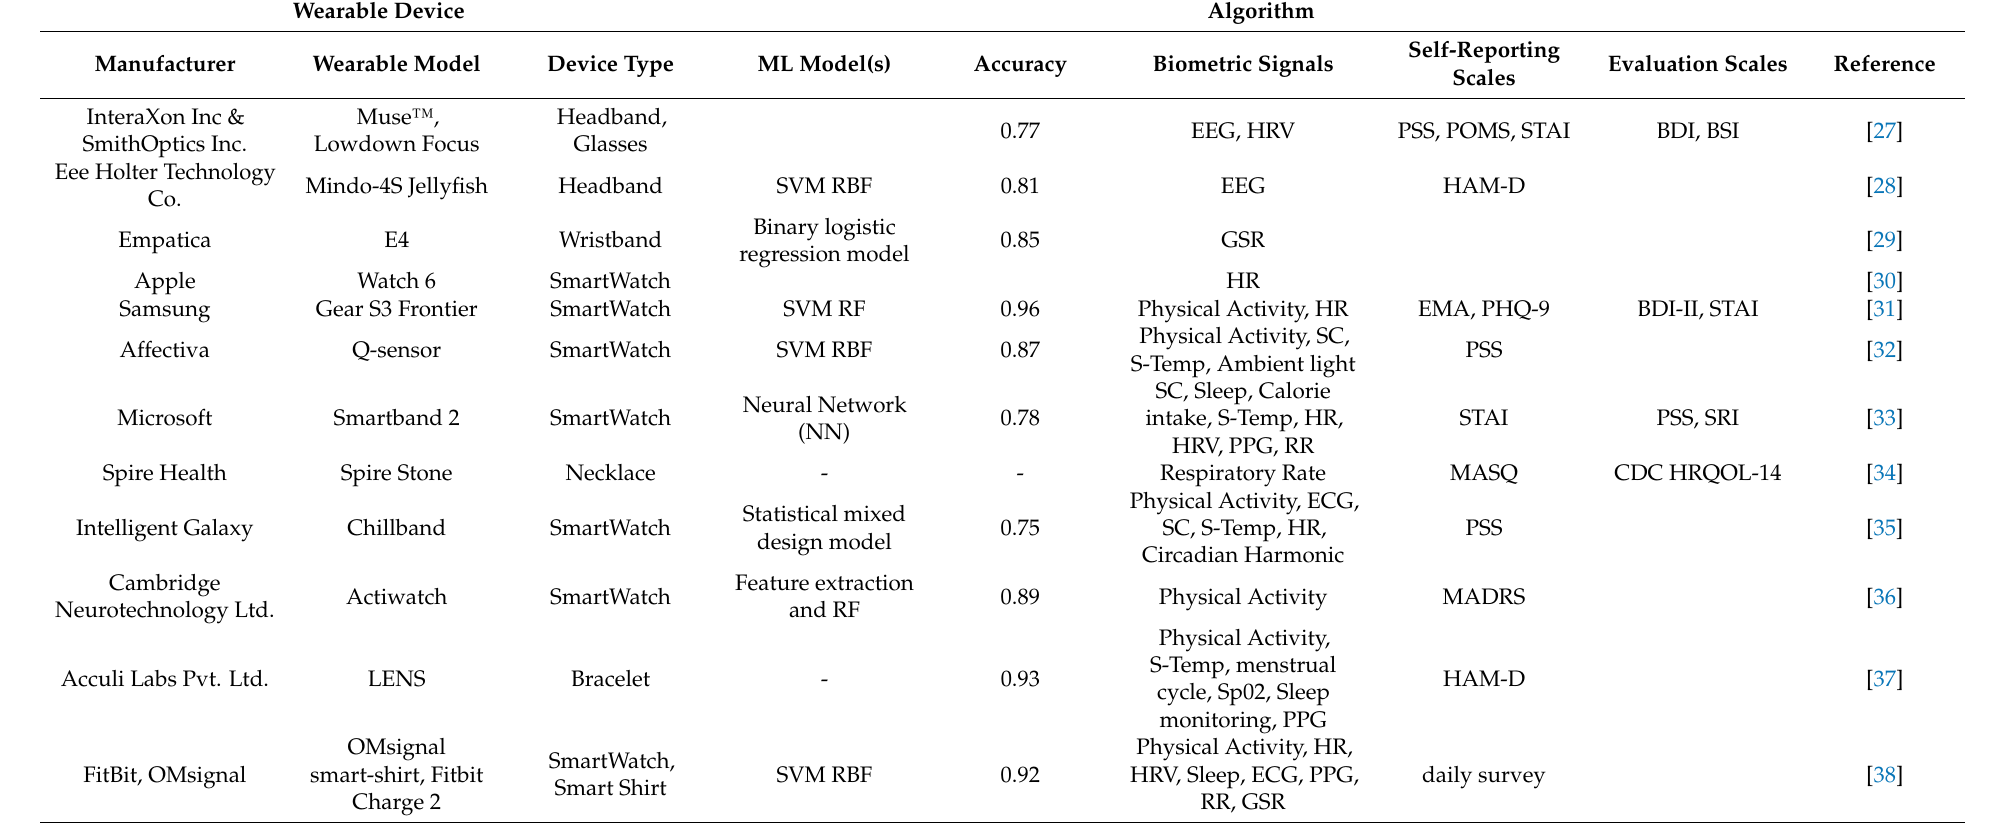
Table 4. Wearable device characteristics for their associated